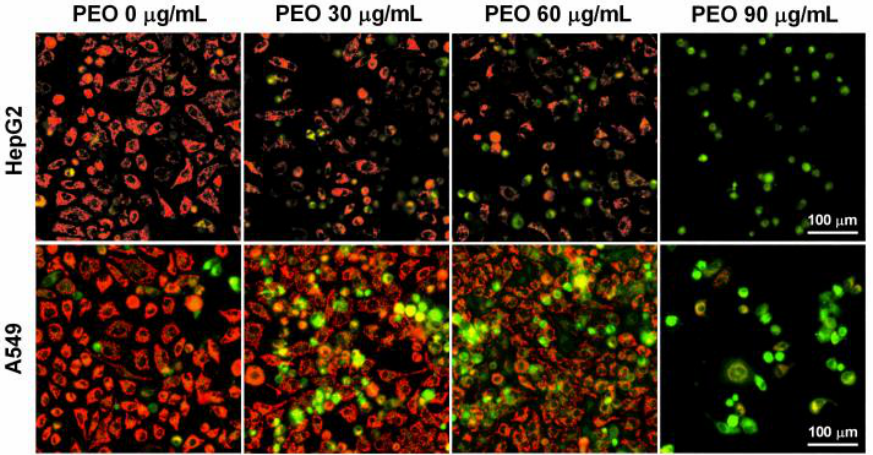
Figure 7. Mitochondrial membrane potential staining of HepG2 and A549 cells treated by PEO. HepG2 and A549 cells were treated with or without different concentrations of PEO (30, 60, and 90 µg/mL) for 24 h, then stained with JC -1 for 20 min at 37 °C. After washing twice with PBS, the cells were photographed using ImageXpress Micro Confocal High-Content Imaging System.